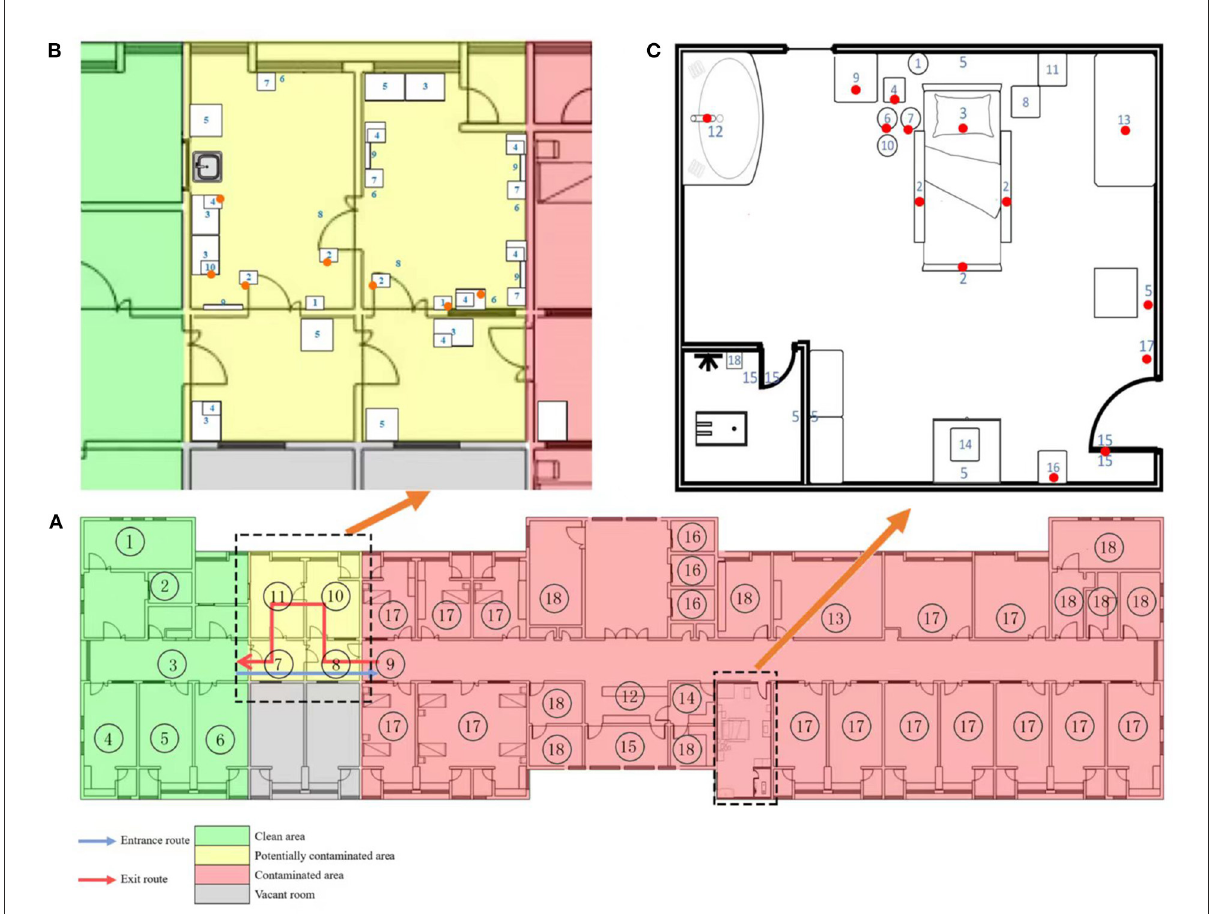
FIGURE1 Layout of functional rooms in designated hospitals and sampling sites of critical patients’ rooms and undressing rooms. (A) A general description of the layout of the inpatient wards where gray, green, yellow, and red regions represent the vacant rooms, cleaning areas, potentially contaminated areas, and contaminated areas, respectively. In field practice, entrances from cleaning areas to contaminated areas and exits from contaminated areas to cleaning areas were allocated on different floors. The road map for entry was: 1 Stairs/2 Cleaning elevator → 3 Clean aisle → 4 PPE dressing room/5 6 Clean Storage → 7 8 Buffer room → 9 Contaminated aisle. The road map for exit was: 9 Contaminated aisle → 8 Buffer room → 10 PPE undressing 1 → 11 PPE undressing 2 → 7 Buffer room → 3 Clean aisle → 4 5 6 shower room. The cleaning areas consist of PPE wearing room, shower room, conference room (which was not marked in this Figure, because it is on other clean floor), and cleaning elevator. The potentially contaminated areas include two undressing rooms, while the contaminated areas consist of patient rooms, 12 nurse station, 13 doctor’s office, 14 dirty washing room, 15 treatment room, 16 contaminated elevator, 17 infected patients’ rooms, and 18 other auxiliary area. (B) As shown in (B) , the potentially contaminated areas consist of two undressing rooms where PPE were removed stepwise in exit levels, along with two buffer rooms. The sampling number and sites include: 1. light switch, 2. door handle, 3. cabinet,